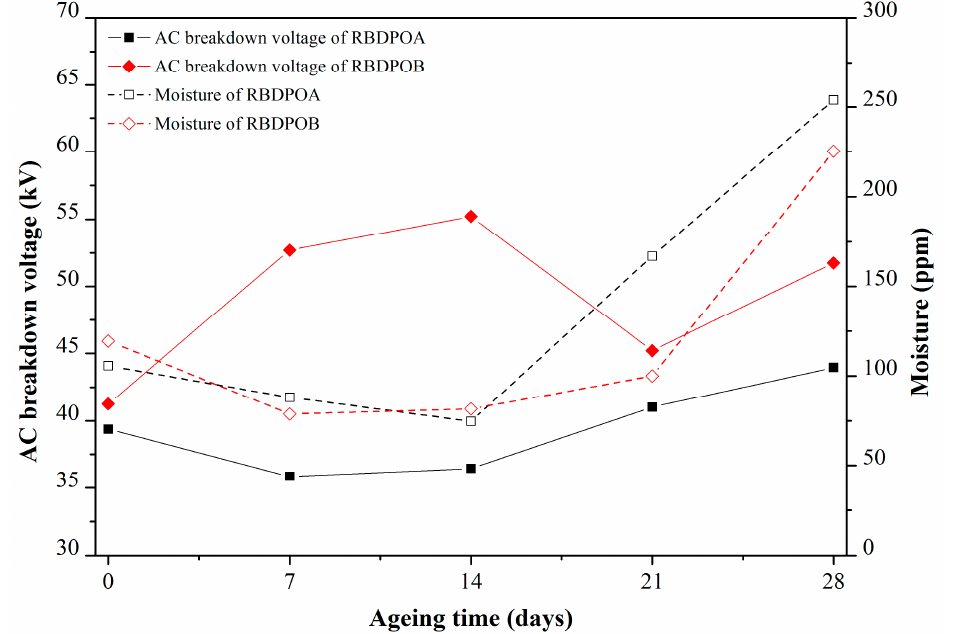
Figure 9. Relationship between AC breakdown voltage and moisture of RBDPO aged at 170 °C under open conditions.